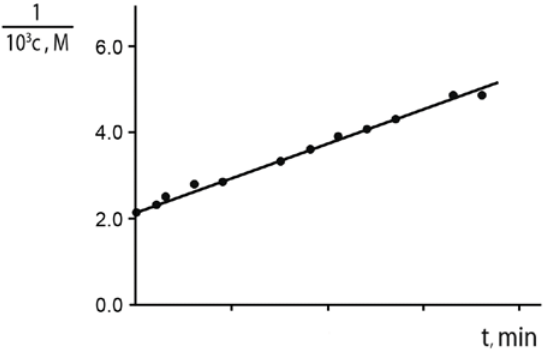
Figure 1. Typical second order plot for the reaction of phenyl mag- nesium bromide ( 1a ) with phenyl tosylate ( 2 ) in THF: tolu- . [PhMgBr] = [PhOTos] ene (7:10) at 90oC; c= [PhOTos] t = 0.471 M.